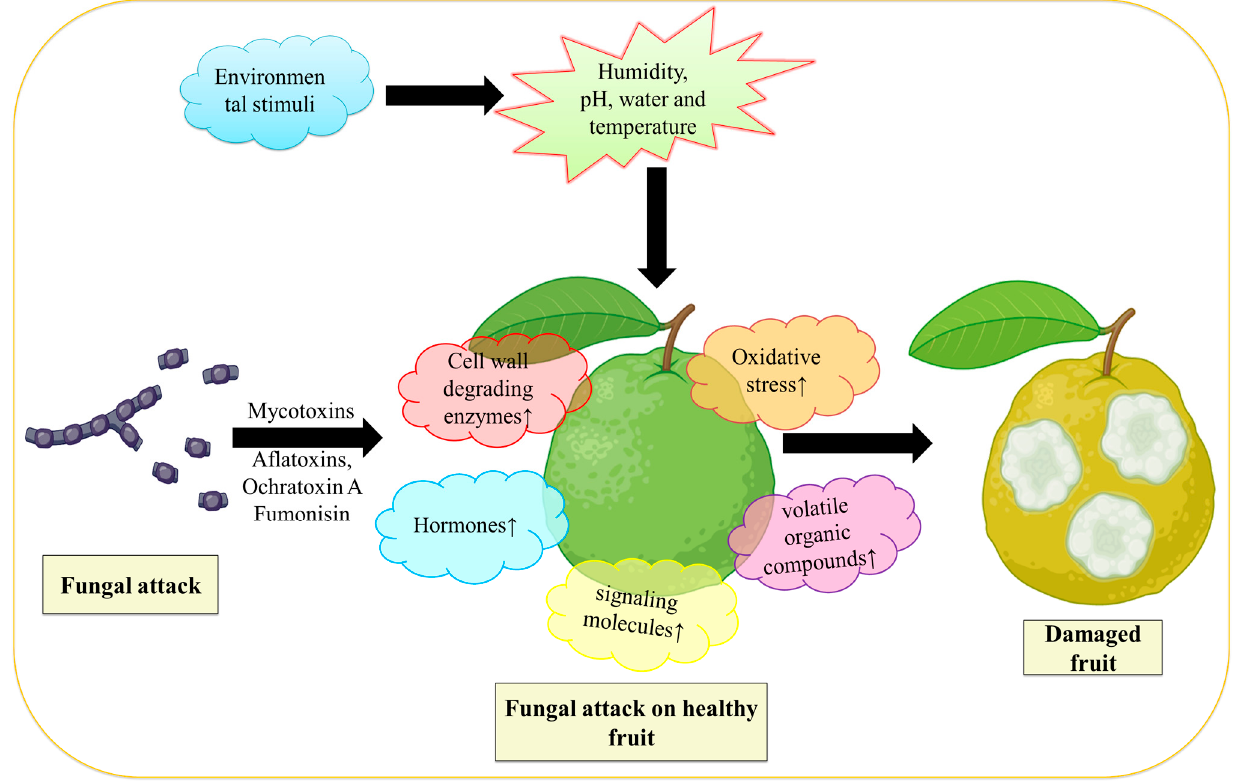
Figure 1. Demonstrate the action of fungus on fruit. During fungal infection, mycotoxins are released from fungi that cause an increase in oxidative stress, volatile organic compounds, phytohormones (like ethylene), and cell wall hydrolases; all these work together that lead to the deterioration of fruit. Figure created with BioRender.com (https://app.biorender.com/biorender-templates)—accessed on 25 November 2022. Table 1. Fruits with postharvest fungal